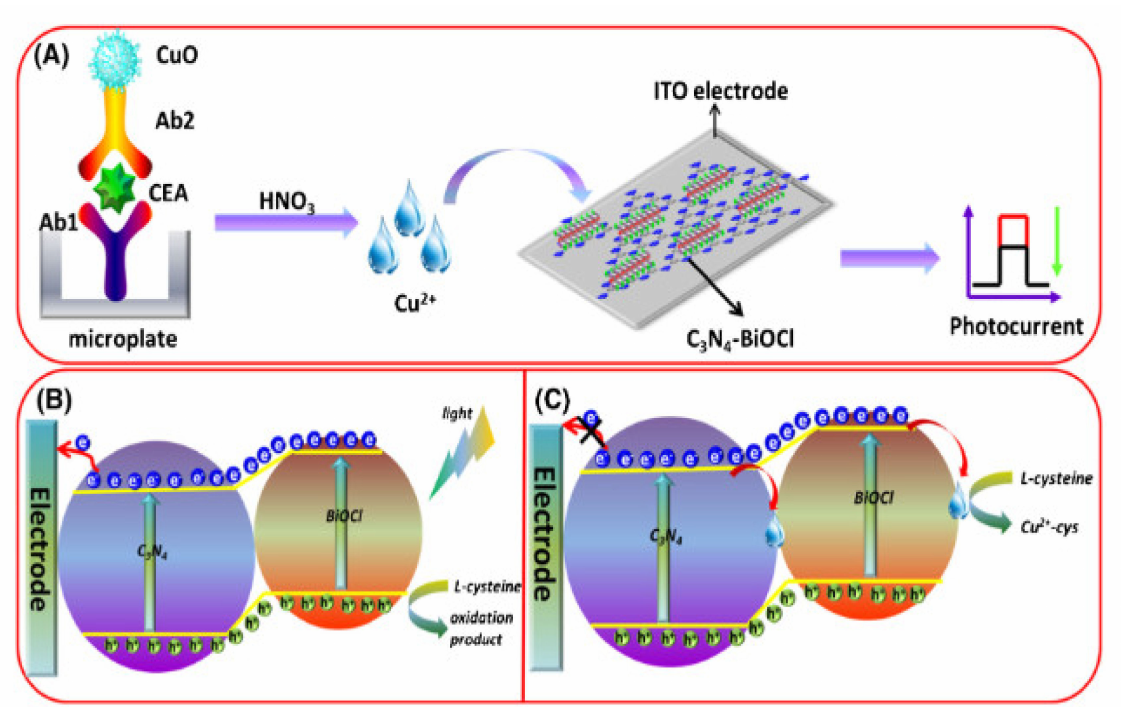
Figure 23. Schematic processes involved in the photoelectrochemical immunoassay of CEA. ( A ): Fabrication process of the biosensor and photocurrent response; ( B ): Photoelectric conversion of C 3 N 4 –BiOCl; ( C ): mechanism of Cu 2+ -quenched photocurrent of C 3 N 4 –BiOCl in the presence of L-cys. Reprinted with permission from [27], published by Springer–Verlag GmbH Austria,